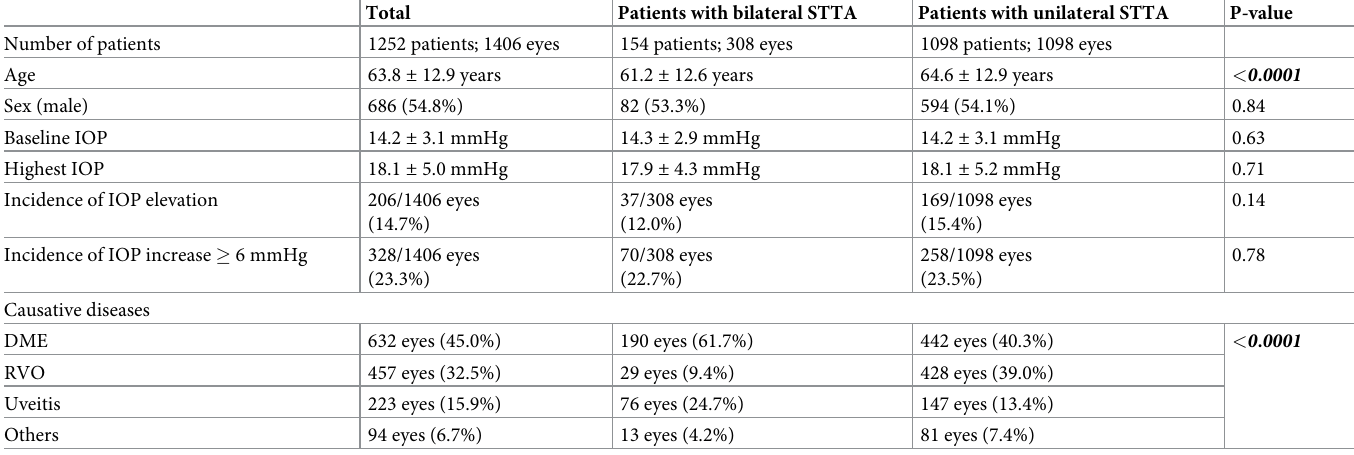
Table 1. Patient